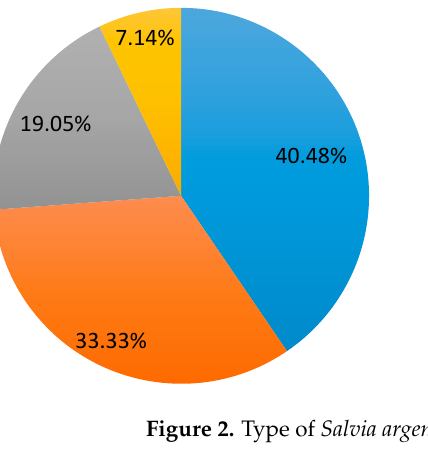
40.48% 40.48% 40.48%